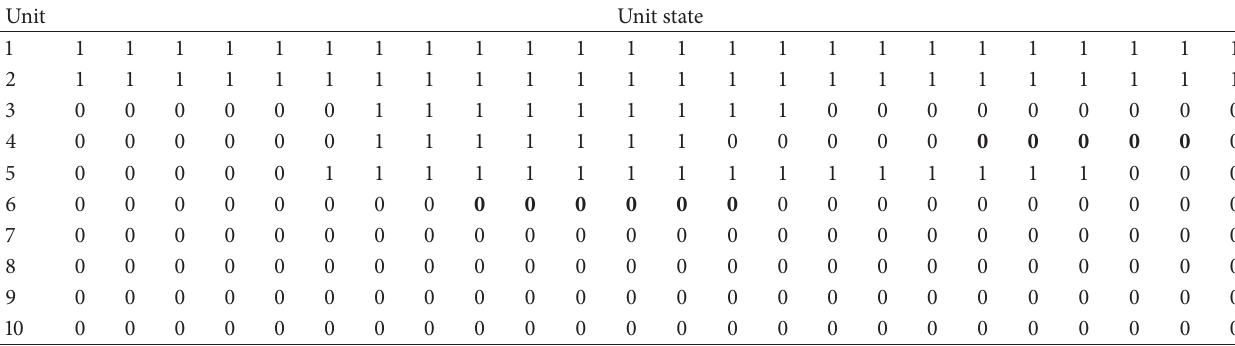
Table 5: Day-ahead UC decision using proposed